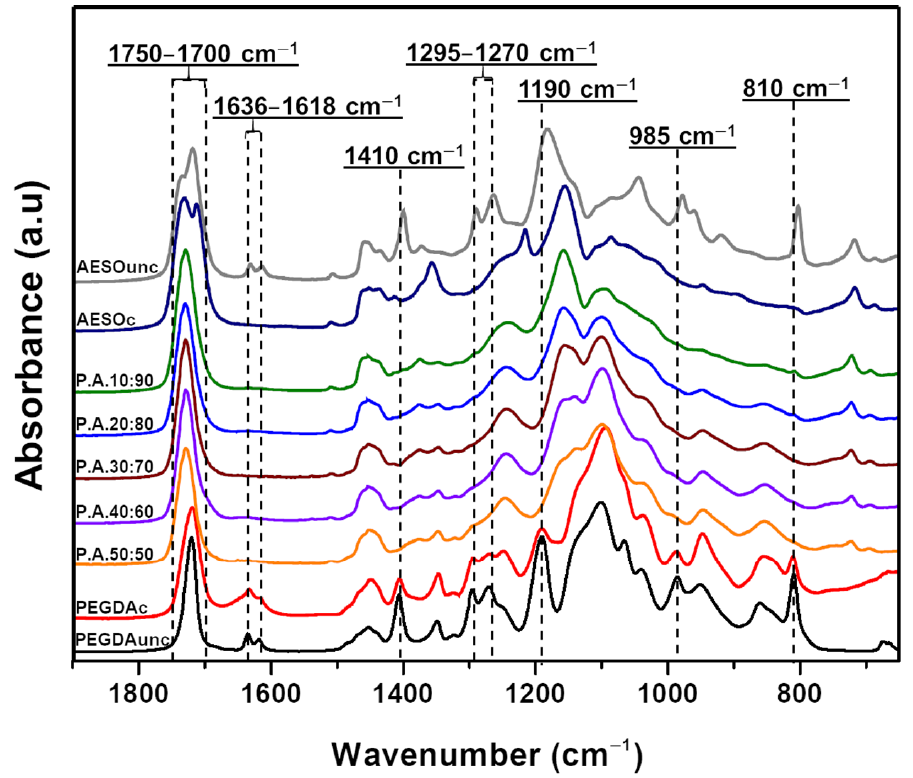
Figure 2. FTIR spectra of PEGDA mixed with different AESO loadings (c = cured; unc = uncured).